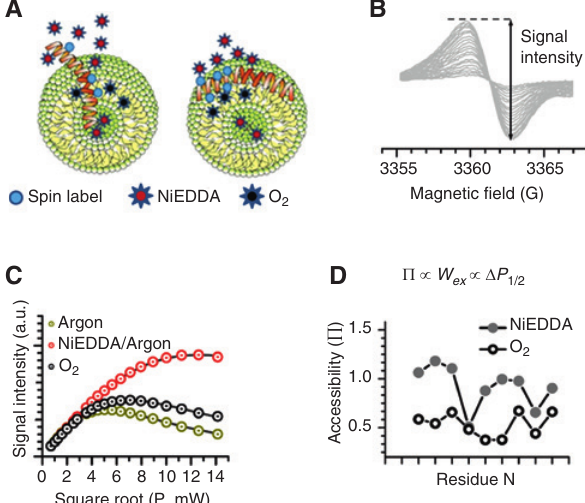
Figure 4: The accessibility to a fast relaxing agent, such as NiEDDA or O can reveal the topology of a membrane protein. 2 (A) A schematic representation of cw-EPR accessibility experiment